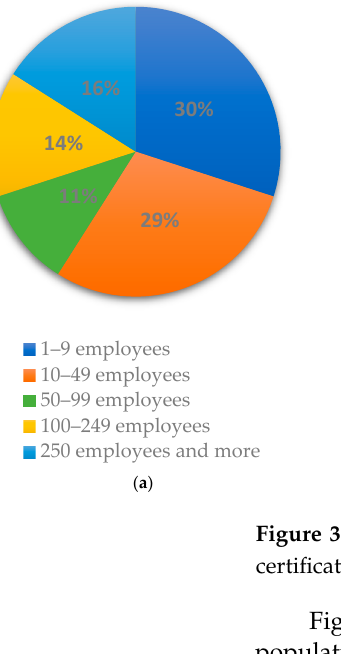
Figure 3. The structure of the surveyed population: ( a ) the number of employees; ( b ) held ISO cer- tificates; ( c ) the internal regulations related to waste reduction.